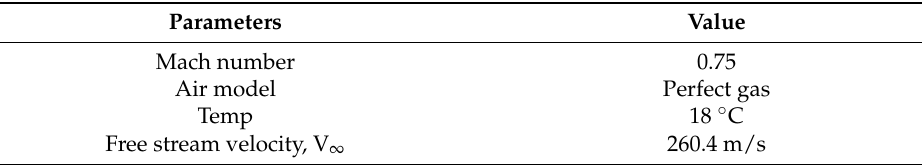
Table 3. Test condition of DLR-F6